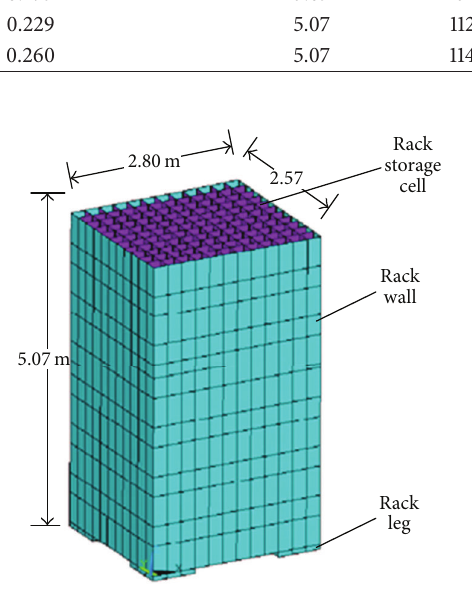
Figure 1: A typical fuel rack